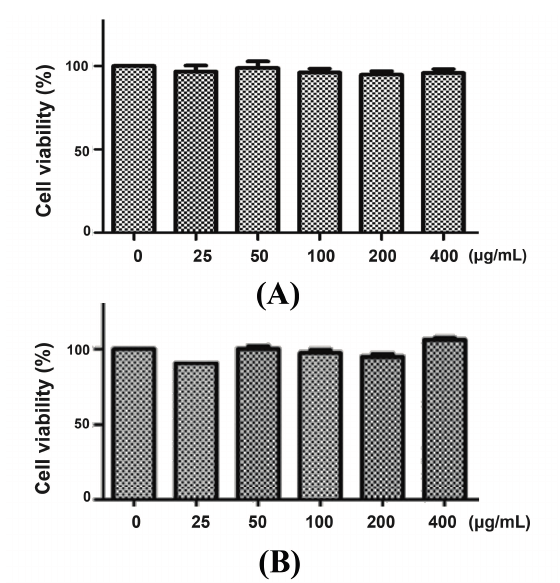
Figure 2. Cytotoxicity of P. chinense extract on L02 cells. L02 cells were treated with different concentrations of P. chinense extract for 12 h ( A ) and 24 h ( B ), then cell viability were assessed by MTT assay. Data are expressed as means ± SEM of at least three independent experiments.